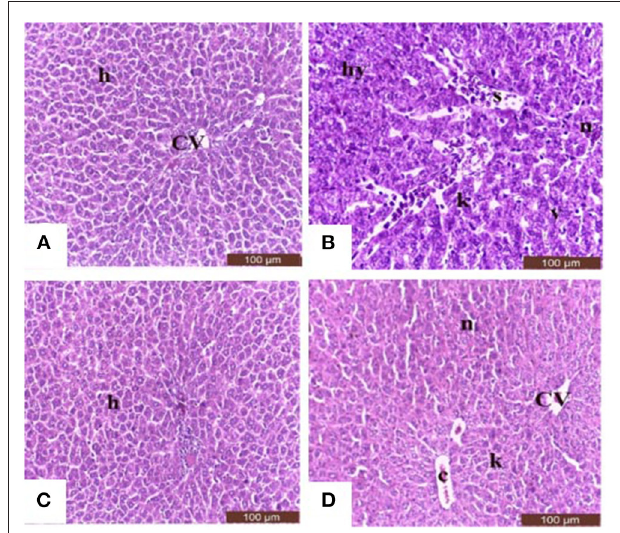
FIGURE 7 | Photomicrographs of hepatic sections stained with hematoxylin and eosin in the control group (A) , the Salsola -treated group (C) , the acrylamide-treated group (B) , and the group co-treated with acrylamide and Salsola (D) . Sections from control and Salsola extract groups (A,C) showed the liver consisted of central vein (CV) surrounded by hepatic cords (h). The cords consisted of large hepatocytes with centrally located nuclei and acidophilic cytoplasm. Sections from the acrylamide-treated rats (B) the liver tissue showed vacular degeneration (v), hydrobic degeneration (hy). The liver tissues showed proliferation of the vonkupher cells (k). The blood sinusoids showed lymphocytic infiltrates (s). Some heaptocytes cells were characterized by necrosis (n) table (6). Co-treatment of rats with acrylamide and Salsola (D) both of the vacuolar and the hydrobic degeneration were localized to few hepatocyte cells. Some cells still in necrotic pattern (n). The vonkupher cells still proliferated but not numerous compared with acrylamide group. Scale bar = 20 µ m (original magnification = 200 × ). The morphometric analysis and scoring of Salsola imbricata extract against acrylamide toxicity were shown on Table 6 . Scale bar = 20 µ m (original magnification = 200 × ).